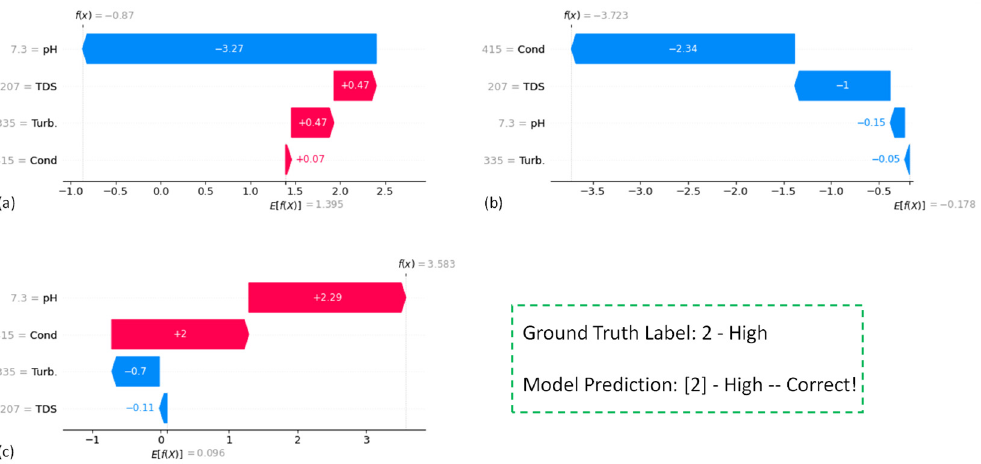
Figure 12. Local interpretations of a correct prediction considering the various possibilities of oc- currence for different As concentrations: ( a ) low; ( b ) medium; and ( c ) high. occurrence for different As concentrations: ( a ) low; ( b ) medium; and ( c )